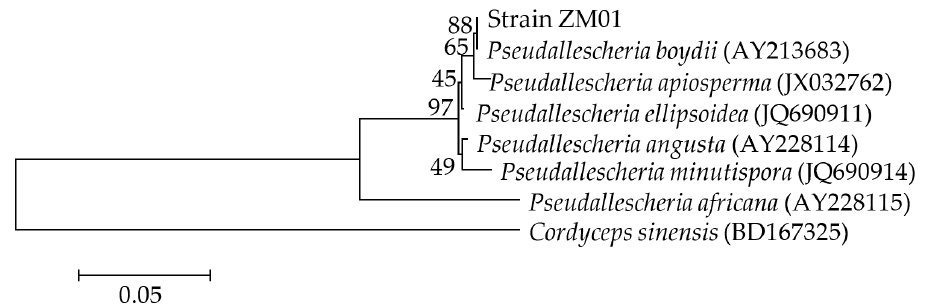
Figure 1. The phylogenetic dendrogram for strain ZM01 and closely related Pseudallescheria strains based on the internal transcribed spacer (ITS) region sequences: The representative tetrahydrofuran (THF)-degrading fungus C. sinensis is used as the root. Numbers after the names of organisms are accession numbers of published sequences. Numbers adjacent to the branches indicate the bootstrap values based on 1000 replicates.